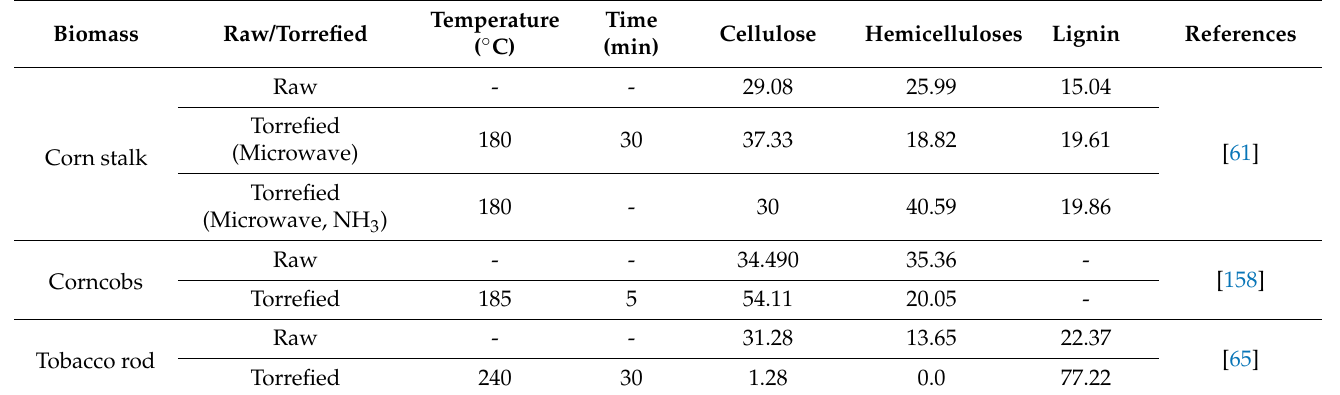
Table 2. Effect of wet torrefaction on the lignocellulosic biomass